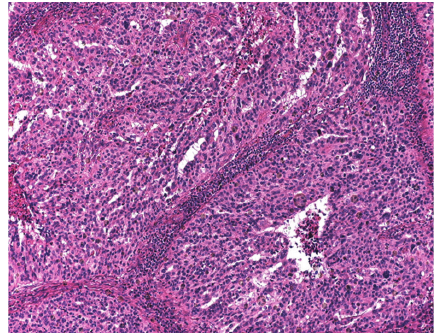
Figure 4: WT-1 positivity in axillary lymph